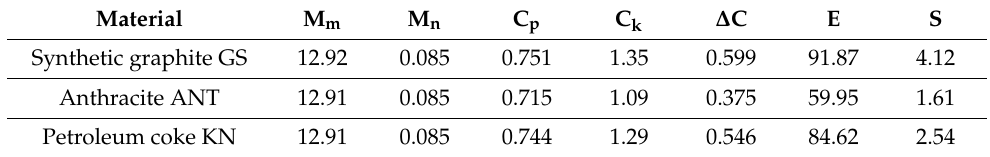
Table 6. The results of recarburization by the carburizer introduction on the liquid metal surface.